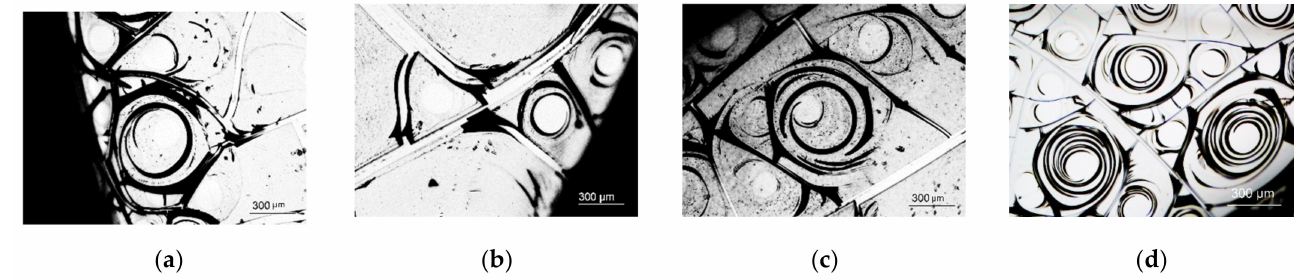
Figure 9. Examples of structures formed in albumin solutions (50 mg/mL) at different MF